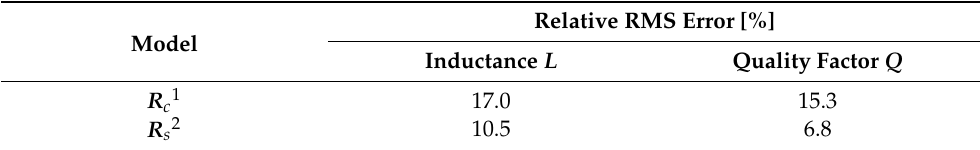
Table 1. On-chip inductor surrogate model accuracy.